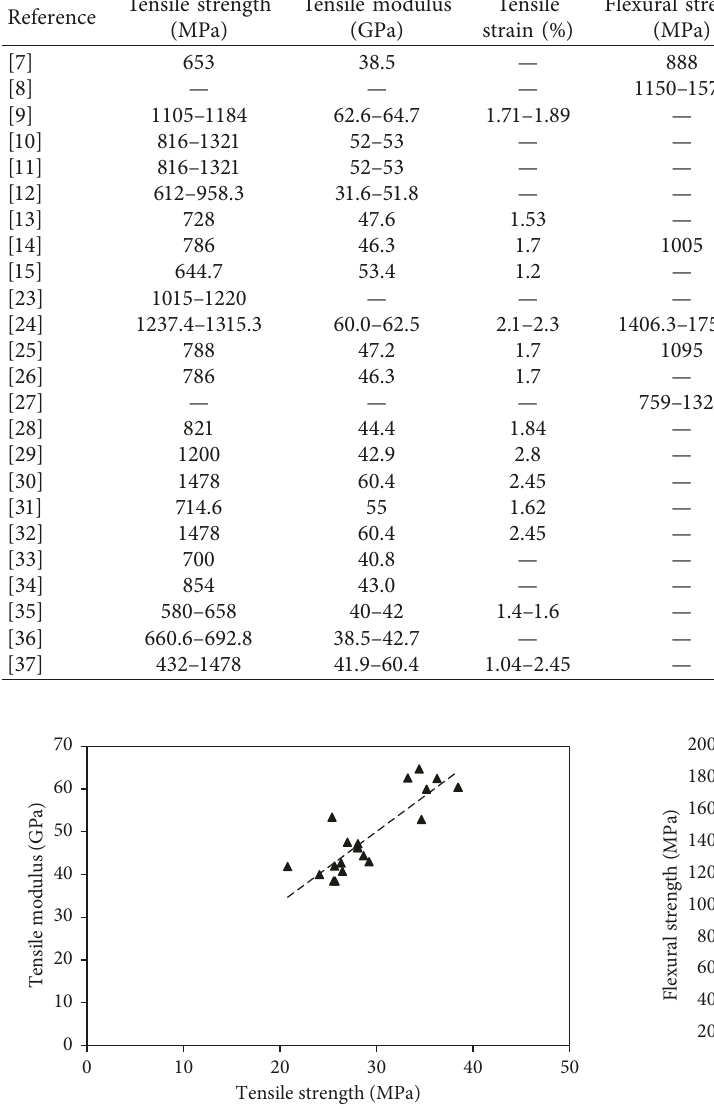
Table 4: Mechanical properties of unconditioned GFRP reinforcing bars. Reference